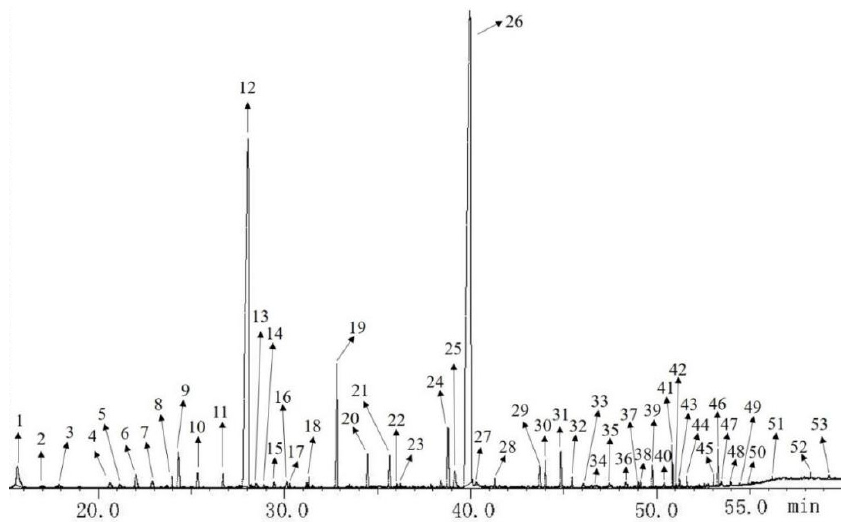
Figure 2. GC-MS total ion chromatogram of volatile compounds of sample f2.